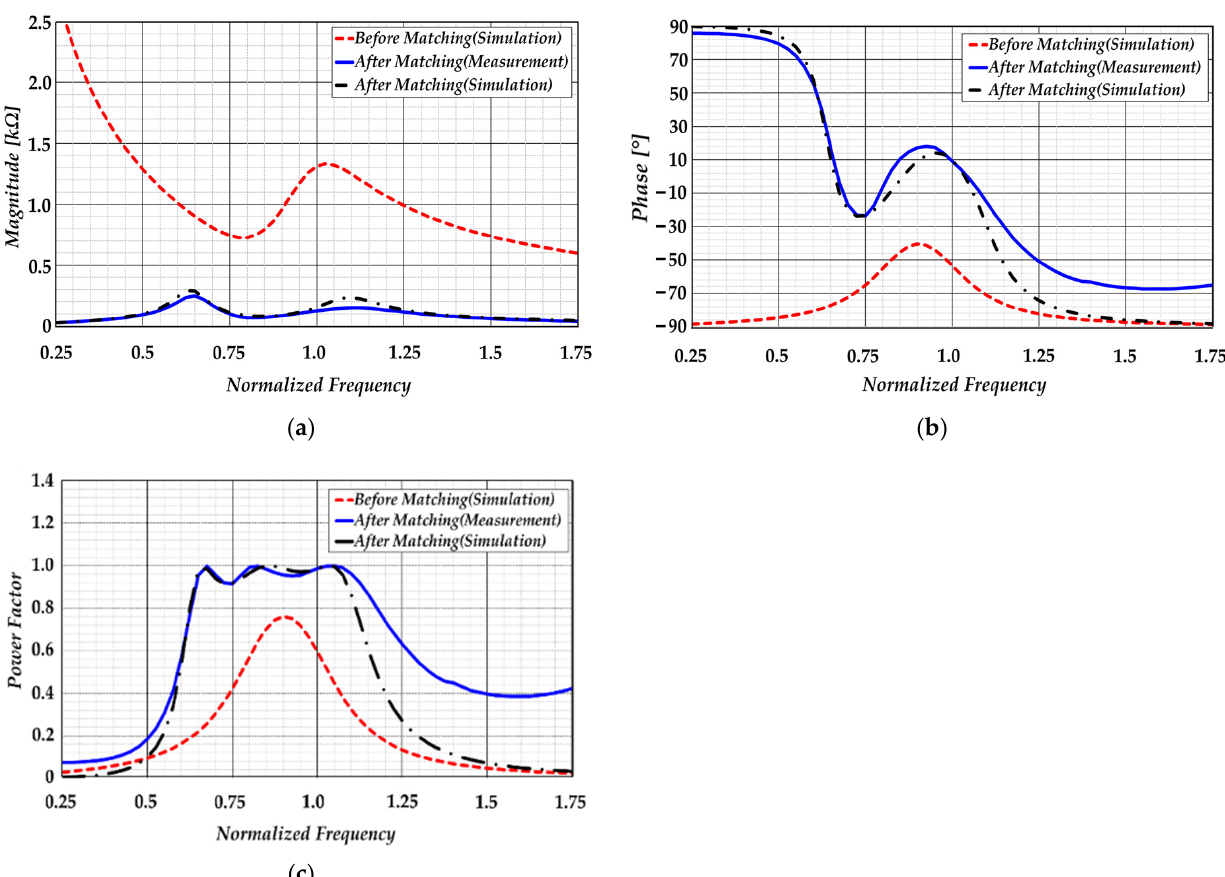
Figure 4. The impedance characteristics and the power factor before and after applying the matching circuit: ( a ) the impedance magnitude; ( b ) the impedance phase; and ( c ) the power factor.